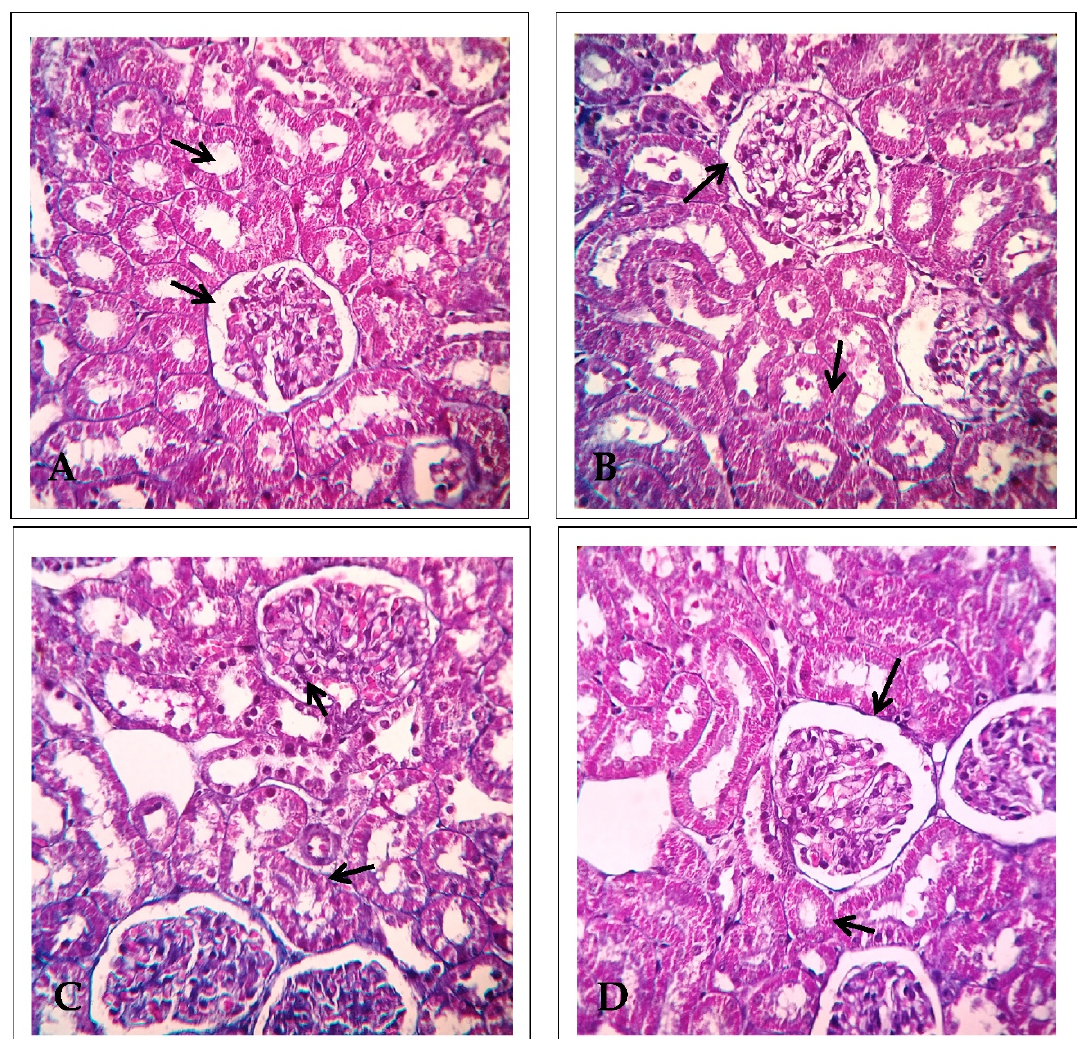
Figure 4. Histopathology of the kidney using Masson’s trichrome stain ( n = 6) (400 × magnification). ( A ) Control kidney shows well-defined glomeruli with a Bowman‘s capsule and renal tubules. ( B ) Lead acetate (PbA; 30 mg/kg body weight (b.w.)) treated kidney shows shrunken glomeruli with a dilated Bowman‘s capsule and degenerated renal tubules. ( C ) N -acetylcysteine (NAC; 200 mg/kg b.w.) + PbA (30 mg/kg b.w.) treated kidney shows renal glomeruli and cortical tubules. ( D ) Ethanolic extract of Celastrus paniculatus seeds (EECP; 800 mg/kg b.w.) + PbA (30 mg/kg b.w.) treated kidney shows normal glomeruli having a well-structured Bowman’s capsule as well as distal and proximal convoluted tubules.